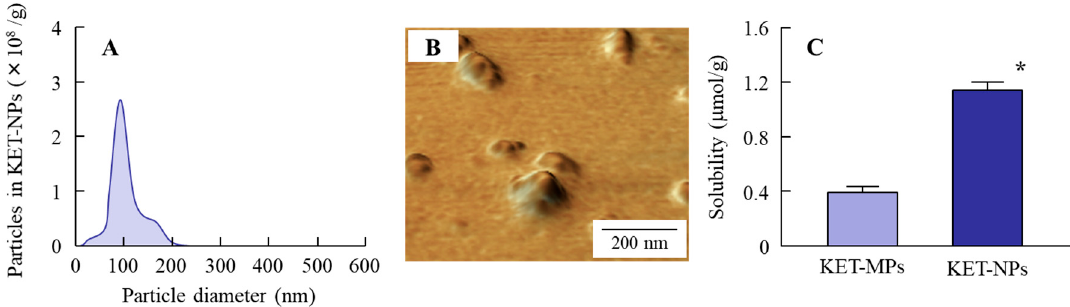
Figure 1. Particle size frequencies ( A ); SPM images ( B ) and solubility ( C ) of ketoprofen particles in the KET-NPs formulation. Mean ± S.E. n = 6. * p < 0.05 vs. KET-MPs formulation. The particle size of ketoprofen in the KET-NPs formulation was 98.3 ± 48.7 nm, and the ratio of nanoparticles to solubilized ketoprofen was 98%.